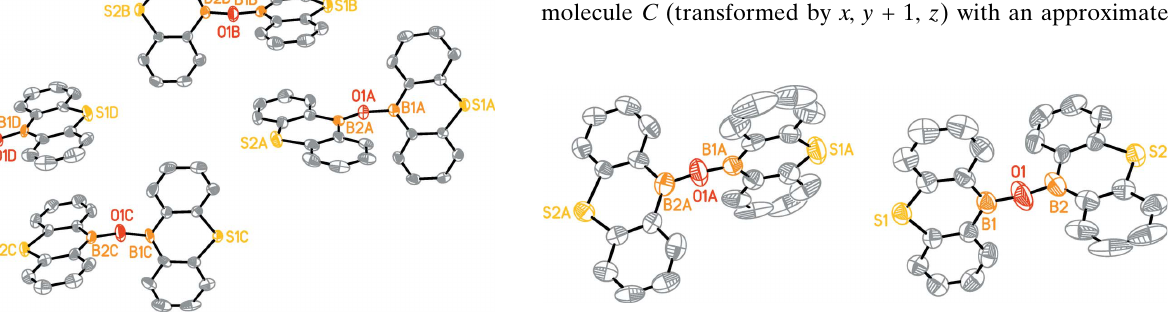
Figure 2 A perspective view of the four molecules in the asymmetric unit of (I). H atoms are omitted for clarity. Only B, O and S atoms are labelled.